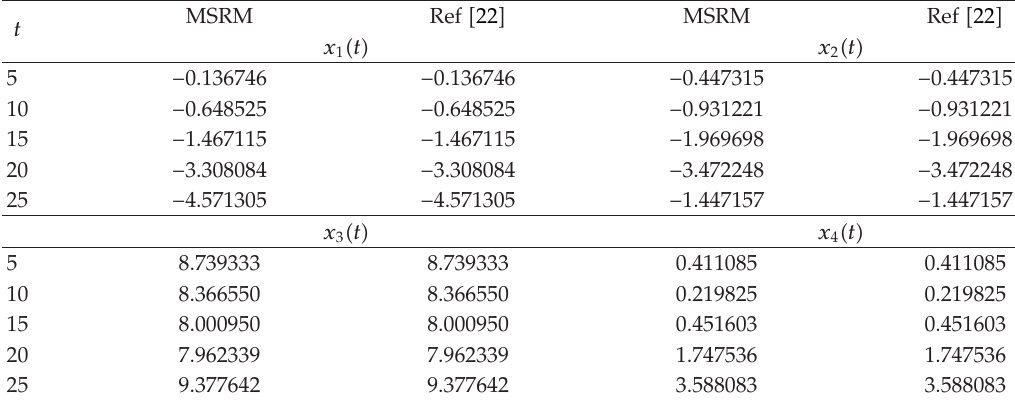
Table 3: Comparison of the numerical solution of the hyperchaotic Chen system obtained by the MSRM and ode45 with d (cid:9) 25.